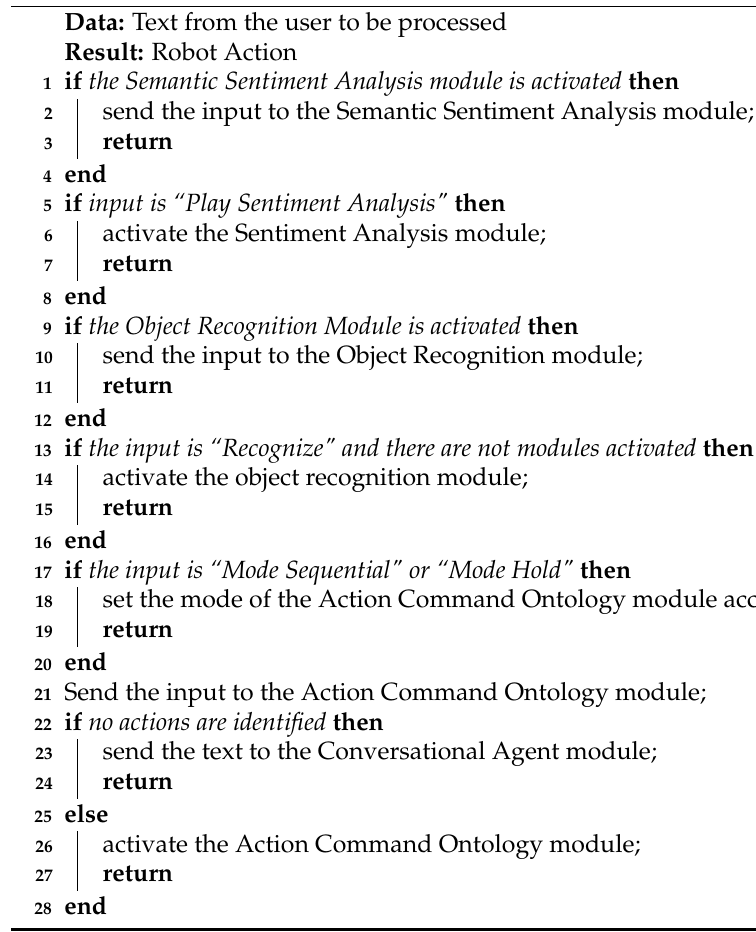
Algorithm 1 Robot Behavior Algorithm of the four modules described in the